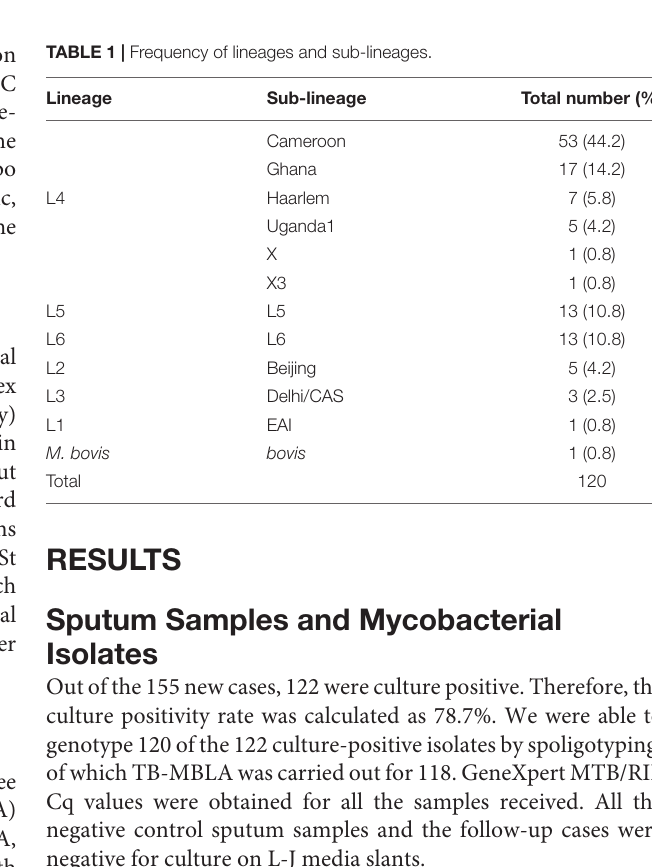
Frontiers in Microbiology |